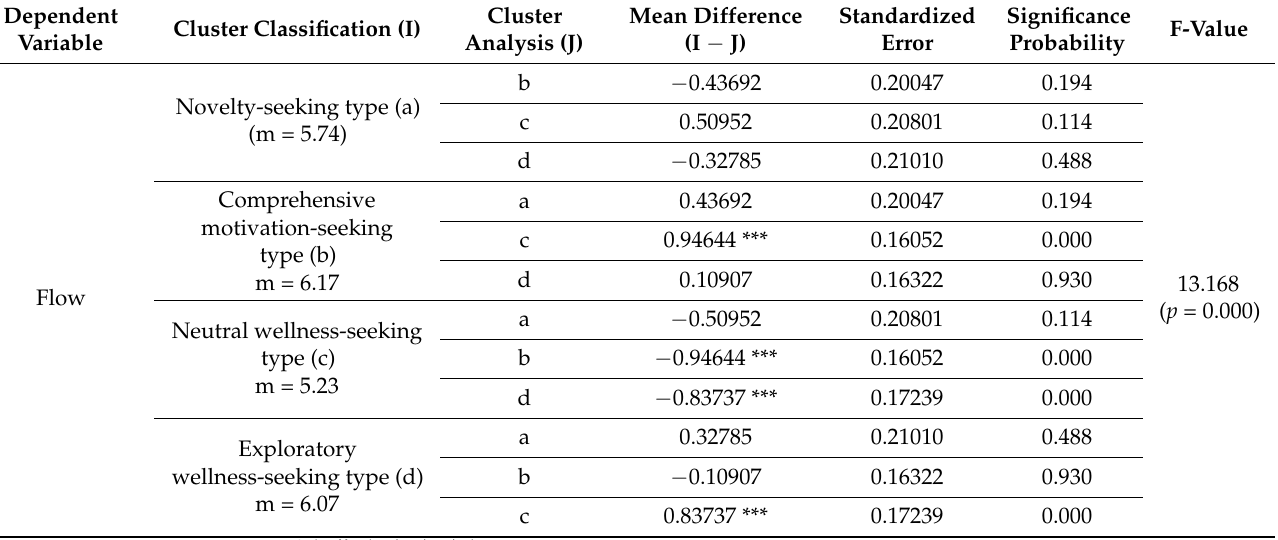
Table 16. Differences in means of flow among wellness tourism product participant